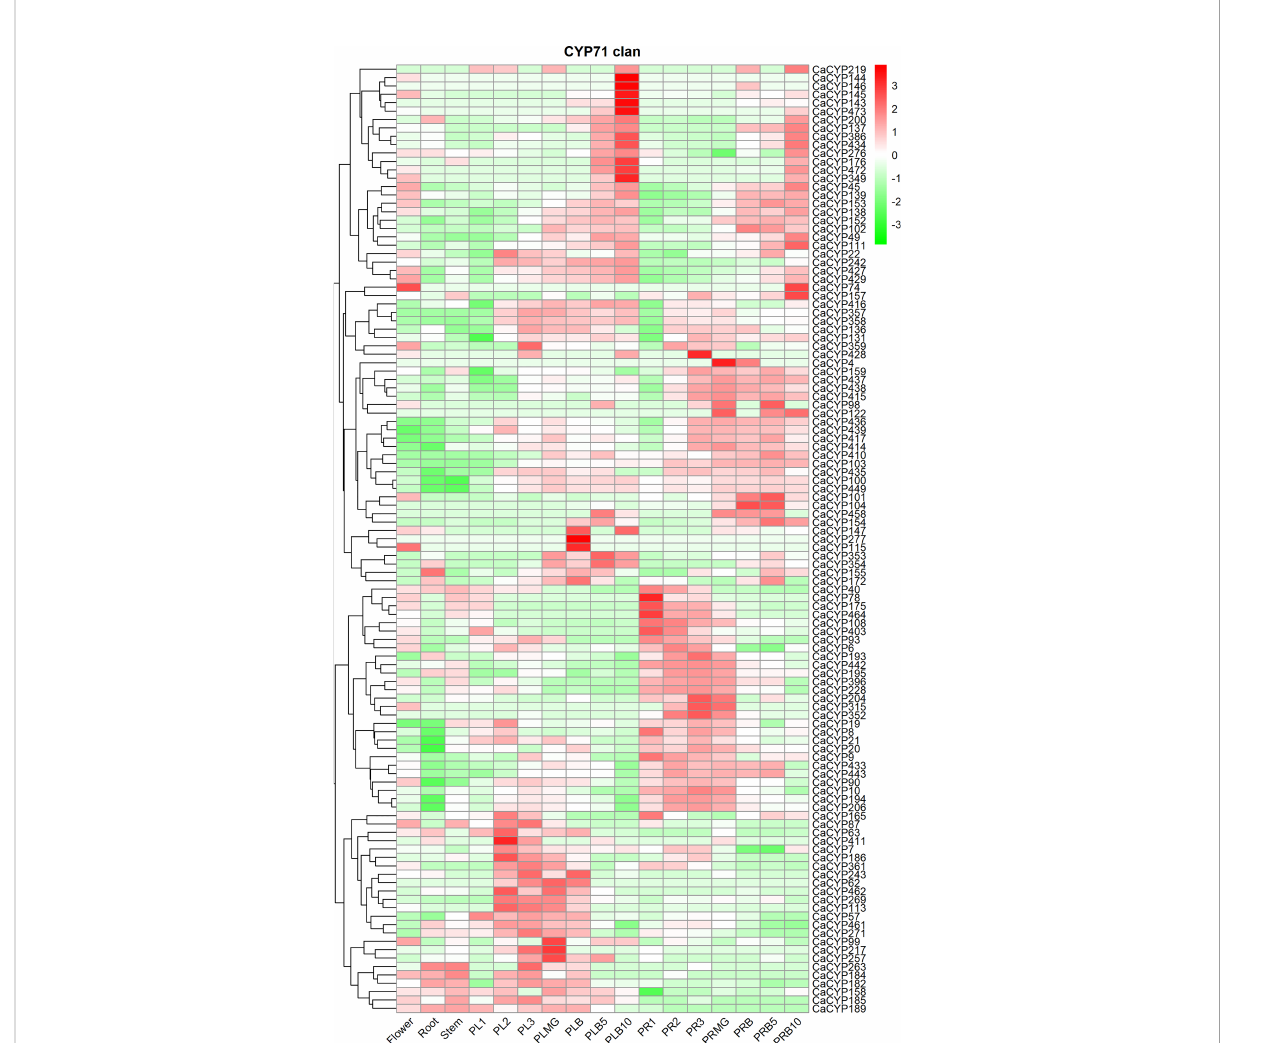
FIGURE 5 Analysis of the expression patterns of the selected CaCYP genes in different tissues and fruit development stages. Heatmaps of normalized RNA- seq data prepared from three biological replicates. The high-expression level is marked by red color, and the low-expression level is marked by green color. The different tissues containing fl ower, root, stem, placenta, and pericarp. PL1, PL2, PL3, PLMG, PLB, PLB5, and PLB10 represent placenta stage 1, placenta stage 2, placenta stage 3, placenta mature green, placenta breaker, placenta breaker plus 5 days, and placenta breaker plus 10 days, respectively. PR1, PR2, PR3, PRMG, PRB, PRB5, and PRB10 represent pericarp stage 1, pericarp stage 2, pericarp stage 3, pericarp mature green, pericarp breaker, pericarp breaker plus 5 days, and pericarp breaker plus 10 days,